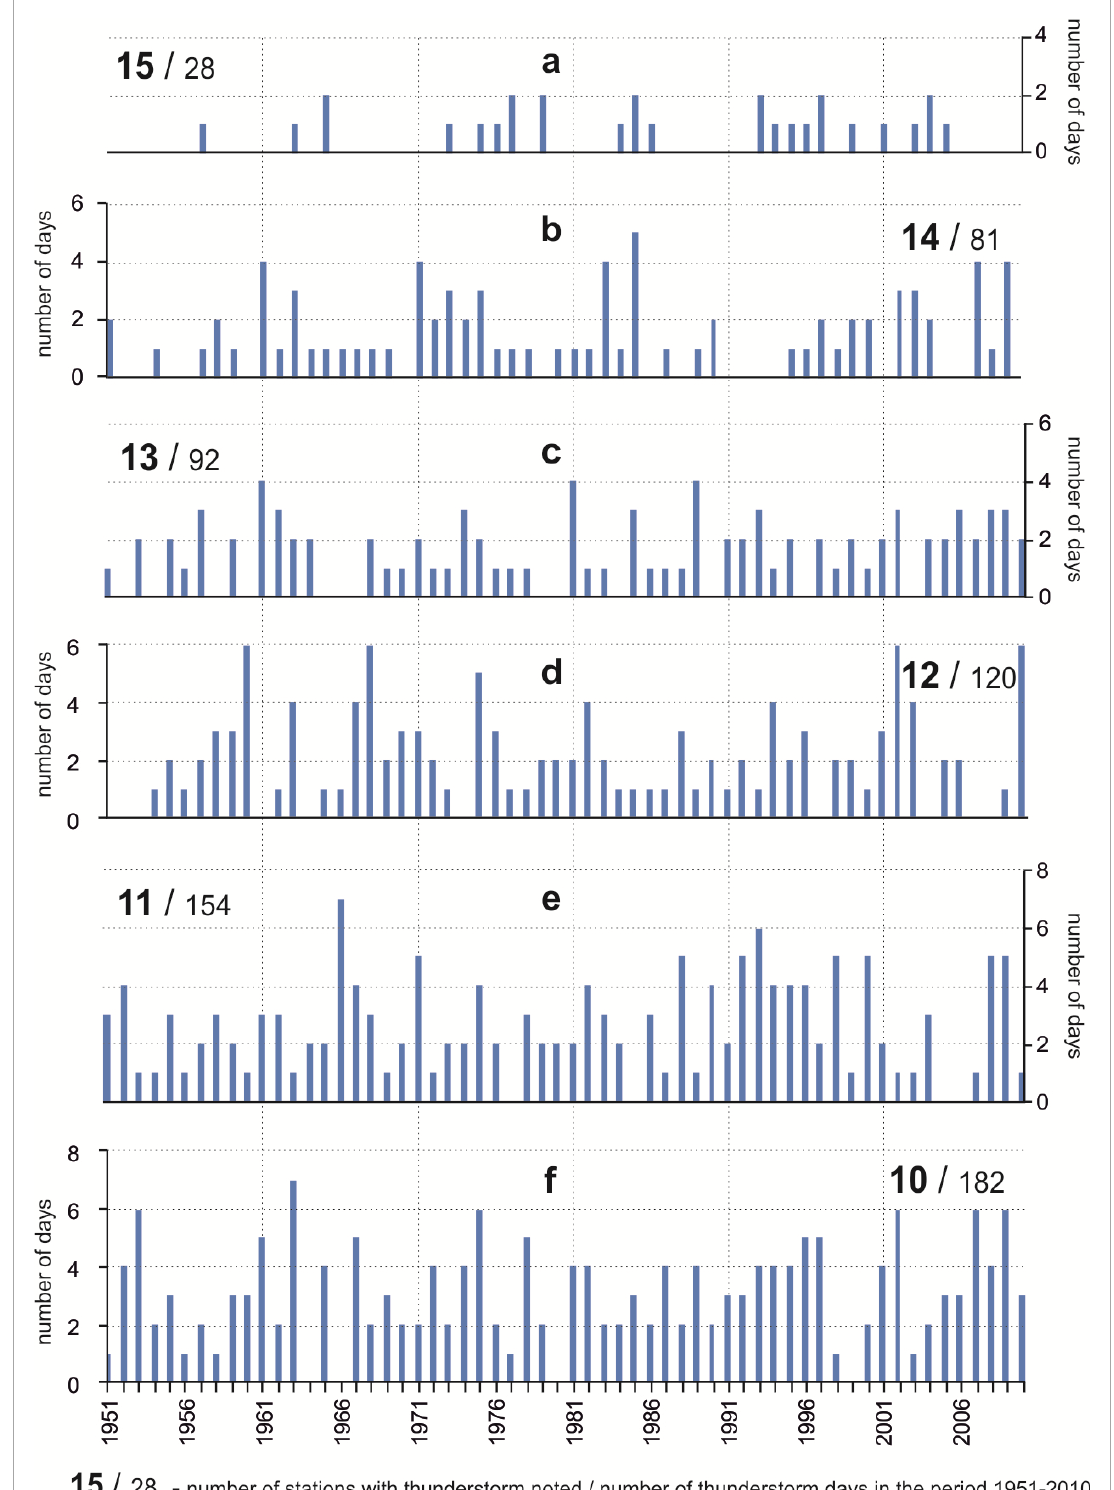
Fig. 7. Annual number of the days with thunderstorm recorded at certain number of stations in period